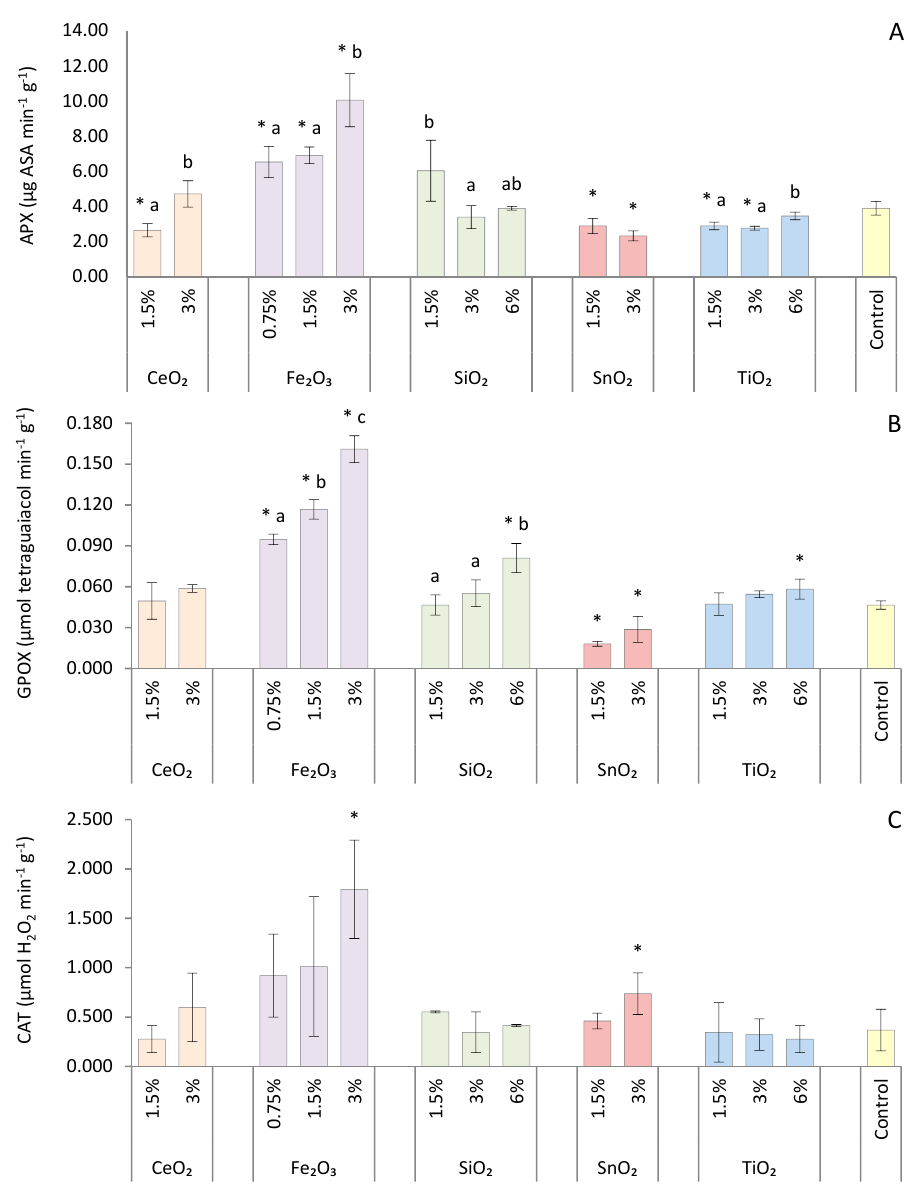
Figure 1. Activity of ascorbate peroxidase ( A ), guaiacol peroxidase ( B ), and catalase ( C ) in oakleaf lettuce seedlings treated with engineered nanoparticles (nano-metal/metalloid oxides; MO-NPs) applied to the leaves at different concentrations. Control plants were sprayed with deionized water. *Denotes significant differences between particular treatments and unexposed control, comparisons were performed by Fisher test ( p ≤ 0.05). Means ( n = 3) for concentrations of given MO-NPs followed by different letters are significantly different at p ≤ 0.05 according to Fisher test. Bars represent standard deviations (± SD).